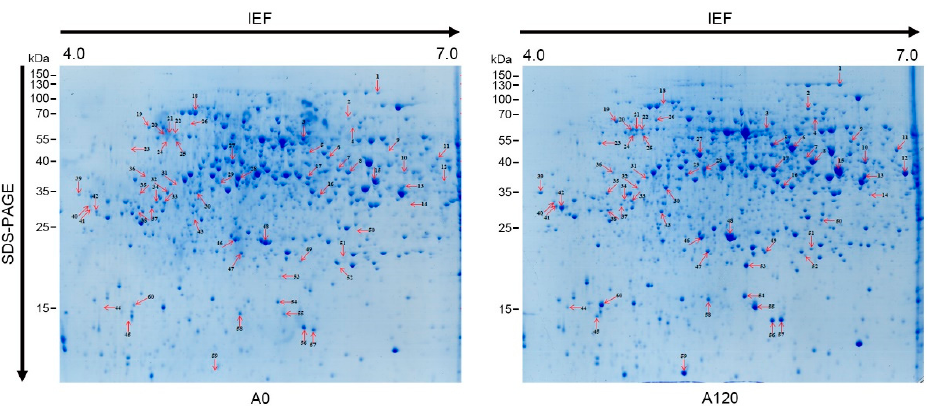
Figure 2. Proteome analysis of control A0 and salt-adapted A120 cell lines. The 50 differentially expressed protein (DEP) spots (45 up- and 5 down-regulated in A120 cells) were identified by 2-DE and MALDI-TOF/TOF analyses. Table 1. Identification of DEPs between control A0 and salt-adapted A120 Arabidopsis callus suspension-cultured cells. Spot No. a Locus